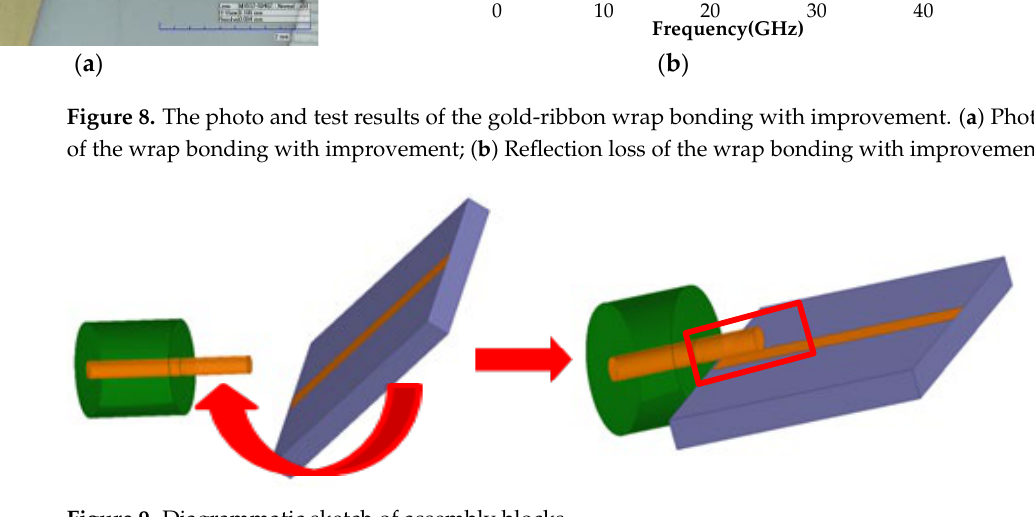
Figure 9. Diagrammatic sketch of assembly blocks.